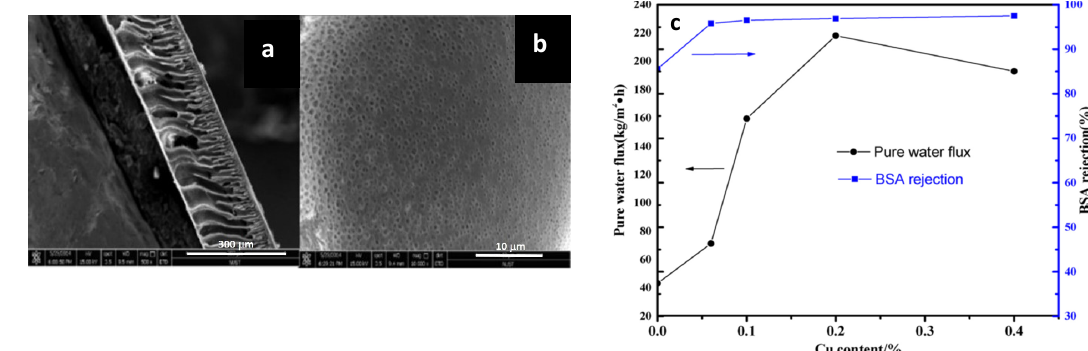
Figure 11. PES UF membranes modified by the SPAES and Cu-NPs incorporation. SEM images of PES/SPAES ( a ) and PES/SPAES/Cu-NPs membranes ( b ). PWF and BSA rejection of the PES/SPAES/Cu NPs membrane ( c ). FRR of the PES/SPAES/Cu-NPs membranes to humic acid (HA), sodium alginate (SA) and BSA. Adapted from Zhang et al. (2018)